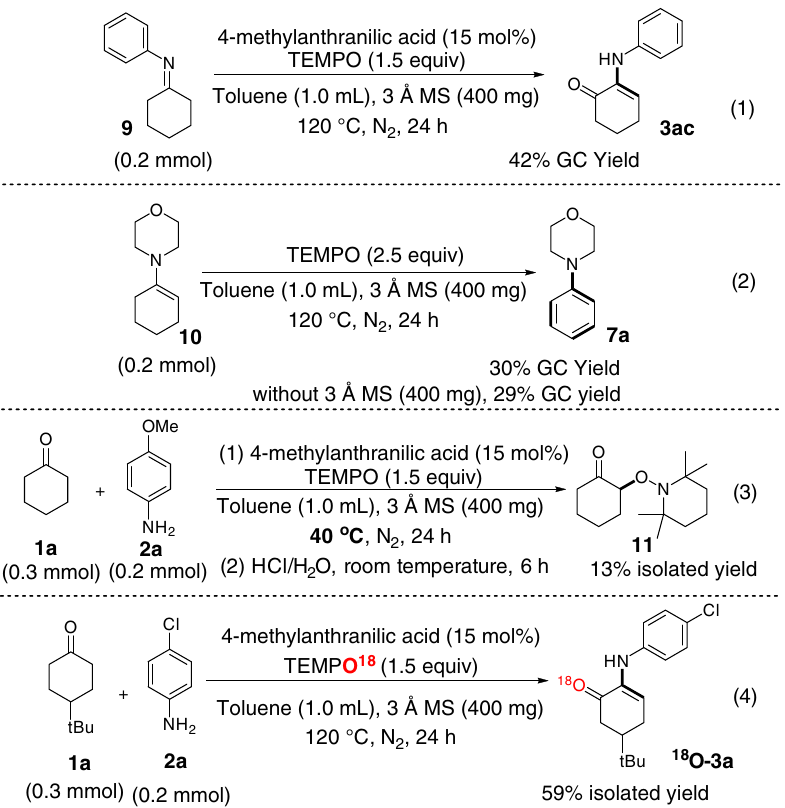
Fig. 5 Experimental studies of mechanism. α -Hydrogen-containing imine reacts with TEMPO to form α -amino enone (1). Enamine reacts with TEMPO to form arylamine (2). The reaction of cyclohexanones, amines and TEMPO at 40 °C gives α -aminoxylated ketone (3). The 18 O-labeling experiment shows that the oxygen atom of ketone group in the α -amino enone product originates from TEMPO